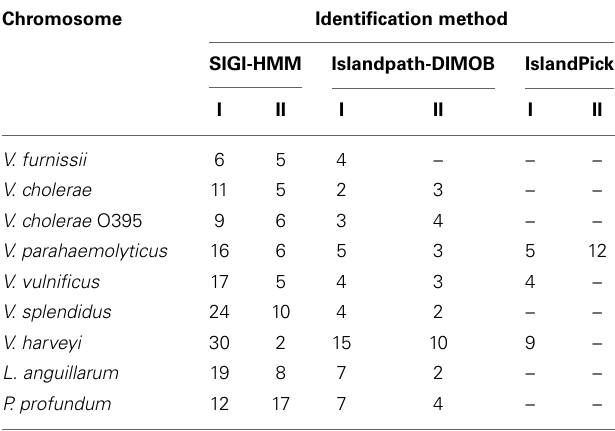
Table 1 | Number of identified GEI in V. furnissii NCTC